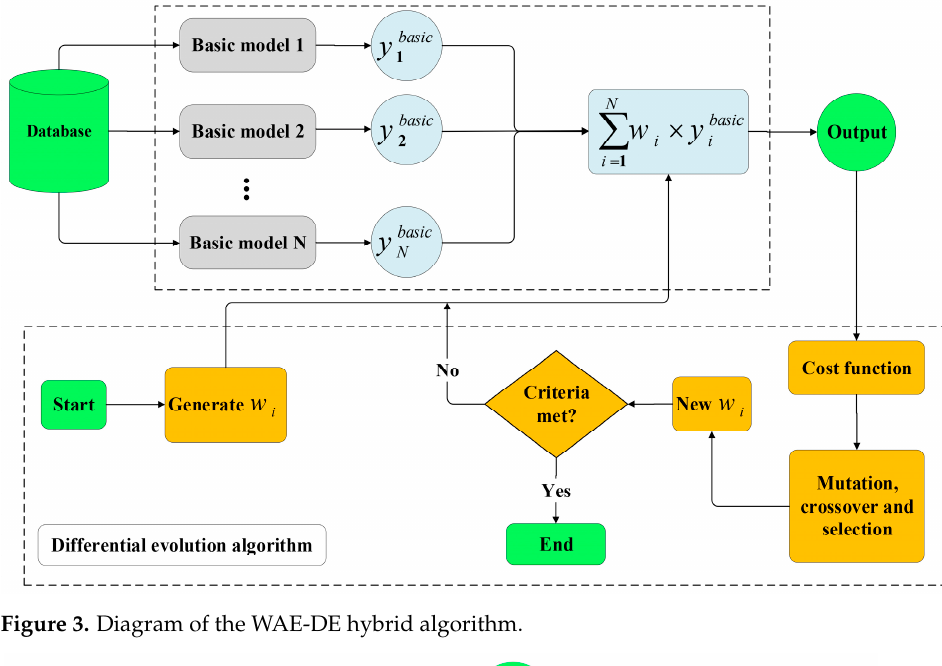
Figure 3. Diagram of the WAE-DE hybrid algorithm.